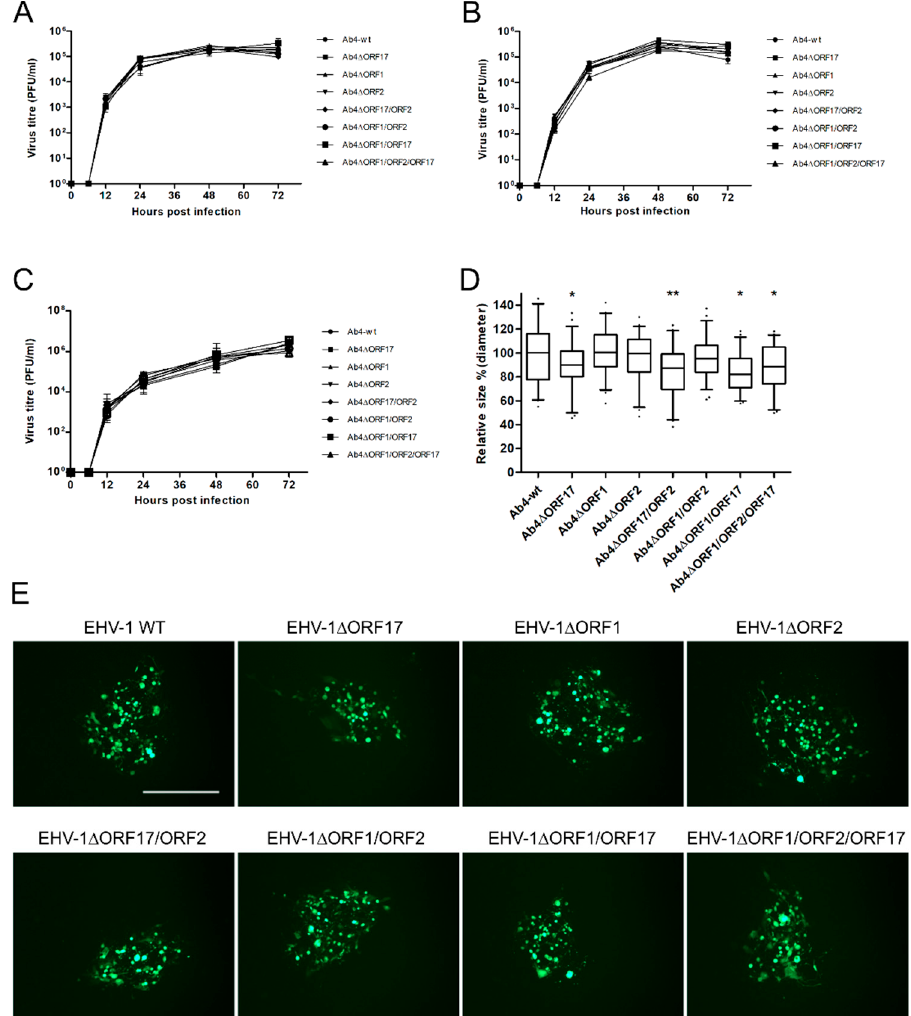
Figure 2. Characterization of mutant viruses. Growth kinetics of mutant Ab4 viruses on ED cells infected at an MOI of 0.1. ( A ) Infected cells and ( B ) supernatant were collected, and virus titers were determined at different time points. ( C ) For EC cells, both cells and supernatants were collected together at each time point and the virus titer was determined. Mean virus titers ± standard deviation are given. ( D ) Mean diameters of 150 plaques were measured for each virus. The plaque diameter of Ab4-wt was set to 100% and the mean diameter ± standard deviation is given; ( n = 3; One-way ANOVA test followed by multiple comparisons test). *— p < 0.05, **— p < 0.01. ( E ) Representative images of plaques induced by the virus mutants on ED cells. Scale bar = 500 µm.